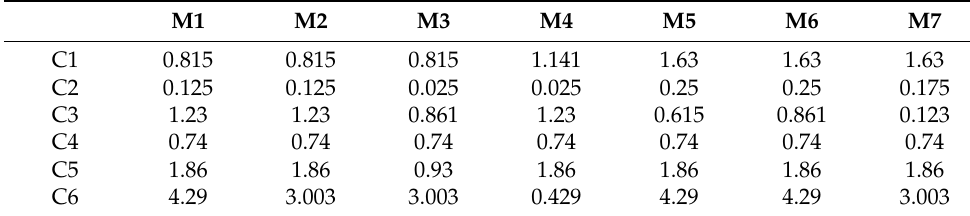
Table 20. DOMINIC normalized weighting matrix.